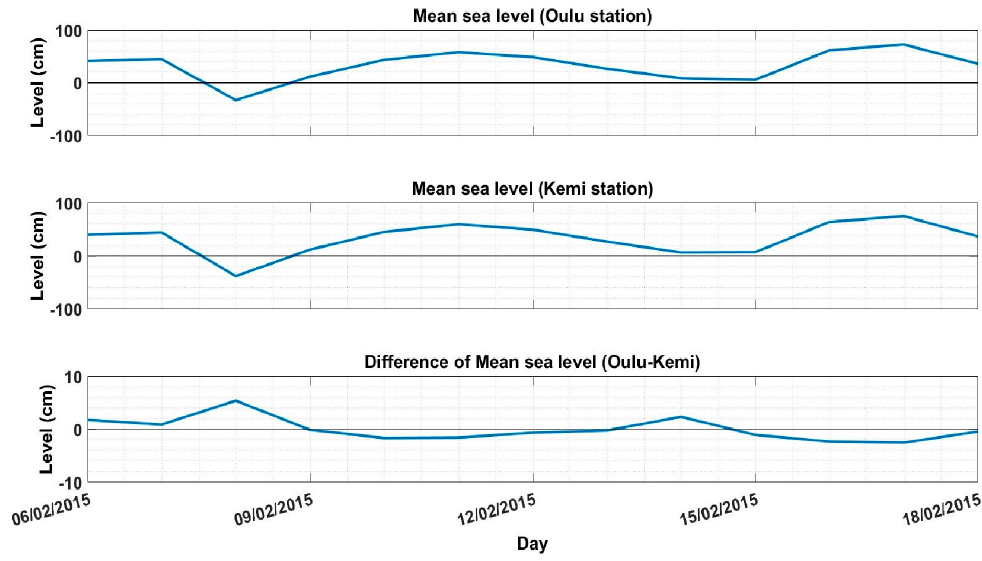
Figure 10. Sea level and sea level differences in Kemi and Oulu stations during 6–18 February 2015.